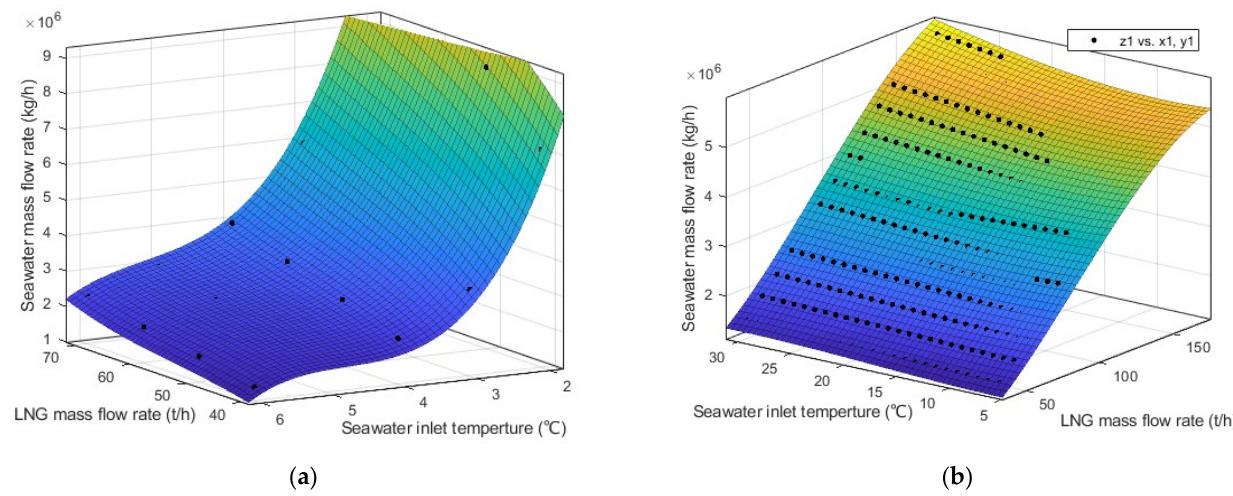
Figure 18. Fitting of the minimum seawater flow of the IFV: ( a ) when the seawater inlet temperature was lower than 6 °C; ( b ) when the seawater inlet temperature was higher than 6 °C.